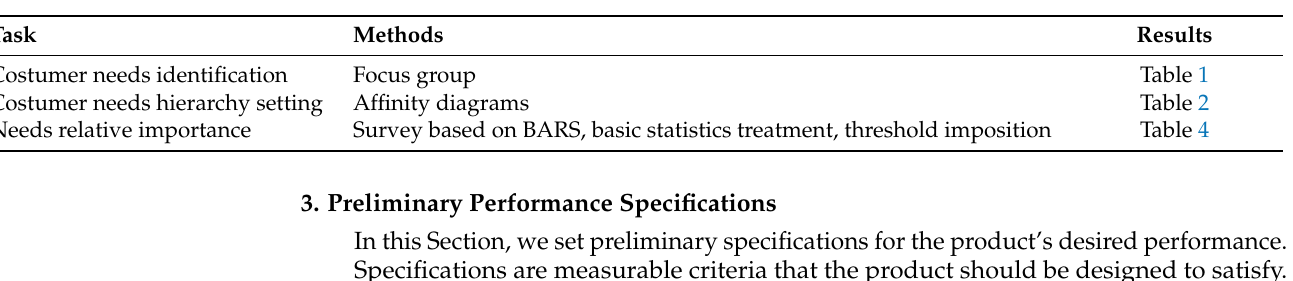
Table 5. Summary of tasks and methods adopted in the Customer needs elicitation